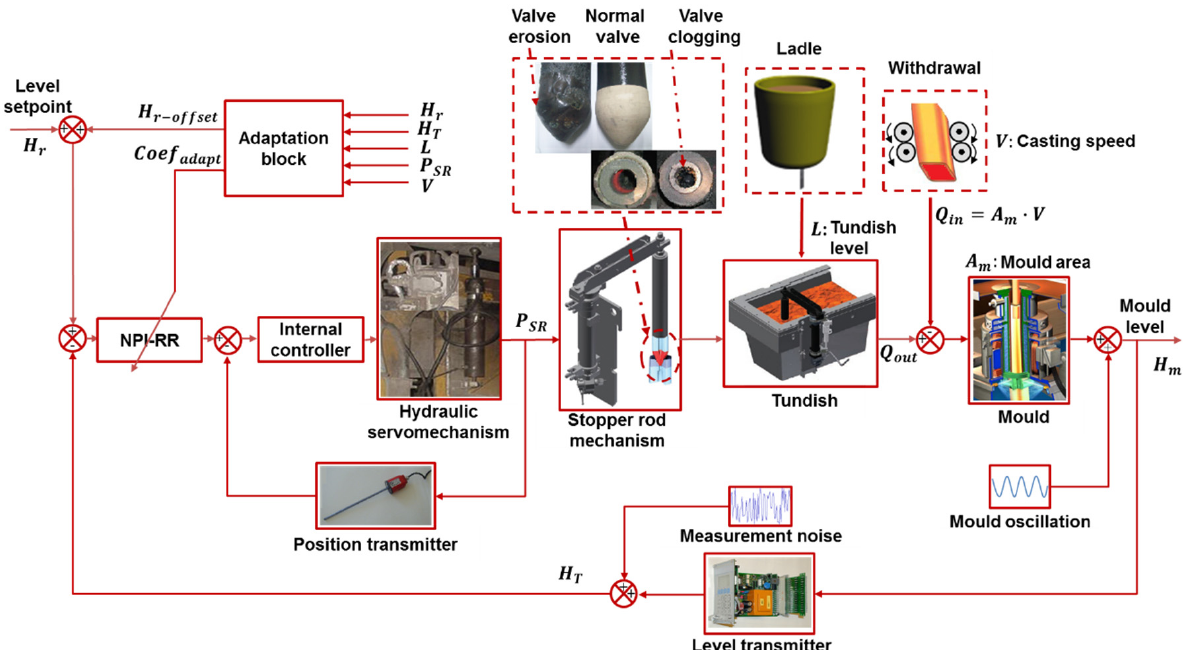
Figure 4. Mold level control (MLC) block diagram with robust nonlinear adaptive control.